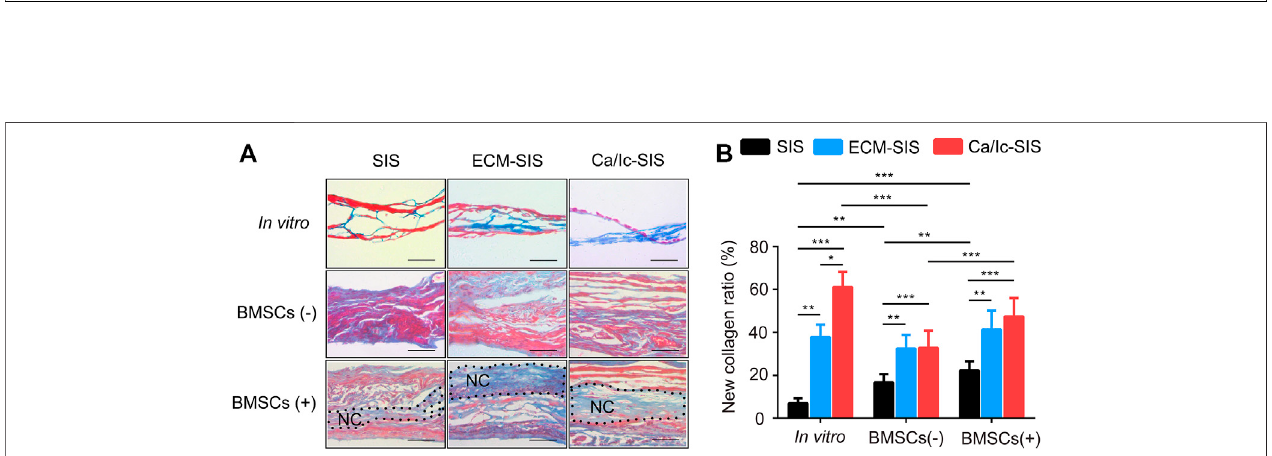
FIGURE5| MTSstainingofthecross-sectionsofthescaffoldimplants. (A) Representativeimagesofallgroupsareshownafter8 weeks.Collagenofthenewbone matrix was stained as blue. (B) Collagen area with blue color and the whole tissue area were measured by ImageJ software, and the ratio was calculated. Five sections were measured for each mouse and four mice were analyzed for each group. *, p < 0.05, **, p < 0.01 and ***, and p < 0.001. Black dotted region represented newly formed collagen (NC). Scale bar: 100 μ m.